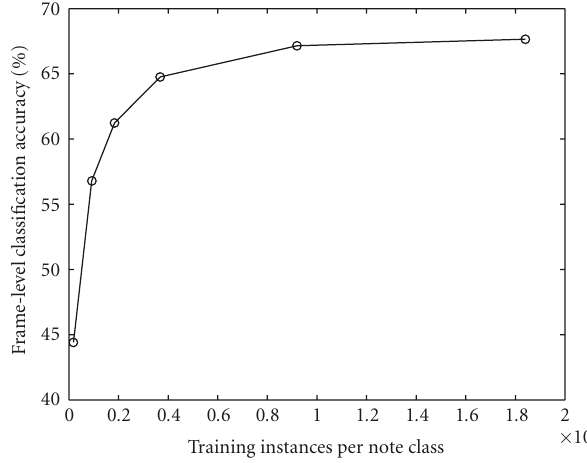
Figure 2: Variation of classification accuracy with number of ran- domly selected training frames per note, per